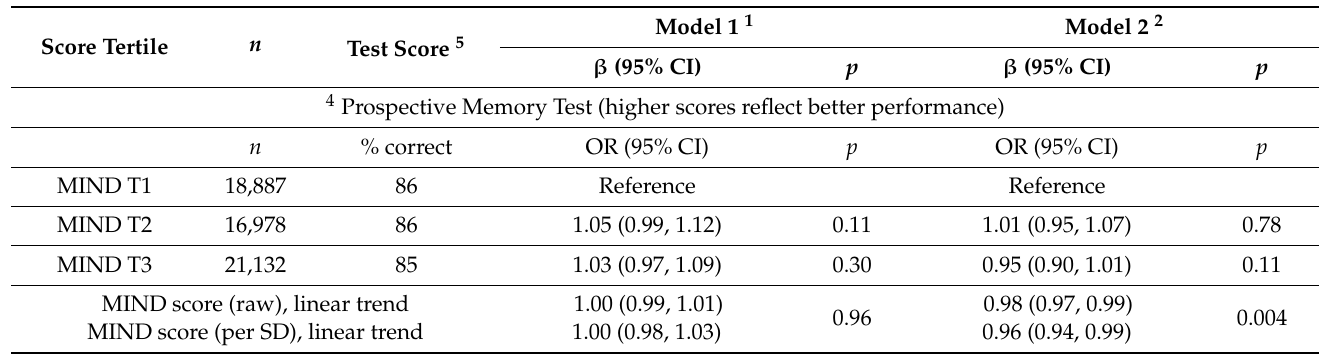
1 Model 1: adjusted for age, sex and self-reported race/ethnicity. 2 Model 2: adjusted for age, sex, race/ethnicity, education, Townsend deprivation index, income, employment status, family history of dementia; history of hypertension, diabetes, heart disease, stroke and depression; self-reported health, smoking, physical activity, BMI, fast meal consumption and energy intake. 3 Positive beta-coefficients for FI (difference in 13-point score) and SDS (difference in number of correct substitutions) and OR > 1 for PM (correct on first attempt) corre- spond to higher performance compared to MIND tertile 1. 4 Negative beta-coefficients for Pairs (difference in (log-transformed) number of errors), RT (difference in time, milliseconds, to respond), Trails A and Trails B (difference in (log transformed) time, deciseconds, to complete) correspond to higher performance compared to MIND tertile 1. 5 Data are raw mean (SD) scores of each cognitive function test.